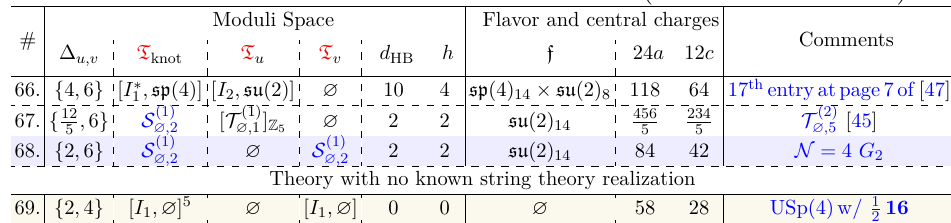
Table 3. Third part of the list of rank-2 theories. In this table we list the isolated theories, those for which no mass deformation connecting them to other rank-2 SCFTs is known. The second column lists the scaling dimension of the CB parameters. Columns 3, 4 and 5 instead list the rank- 1 theories describing the massless states on the connected components of the CB singular locus, see table 4 for how to read these entries. The Z subscript indicates discrete gauging. Continuing, d ‘ HB indicates the quaternionic dimension of the HB while h that of the ECB. Column 8 indicates the flavor symmetry of theory, along with the level, followed by the a and c central